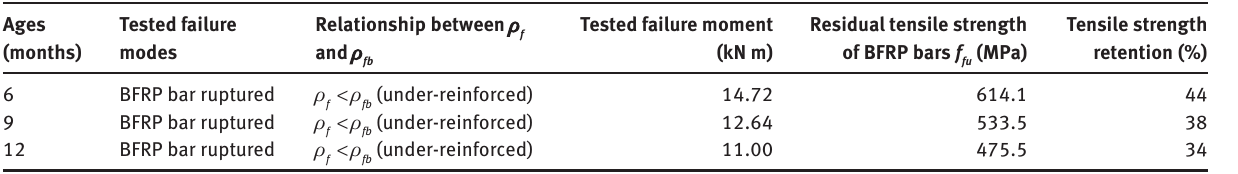
Table 5: The ultimate strength of BFRP bars at different